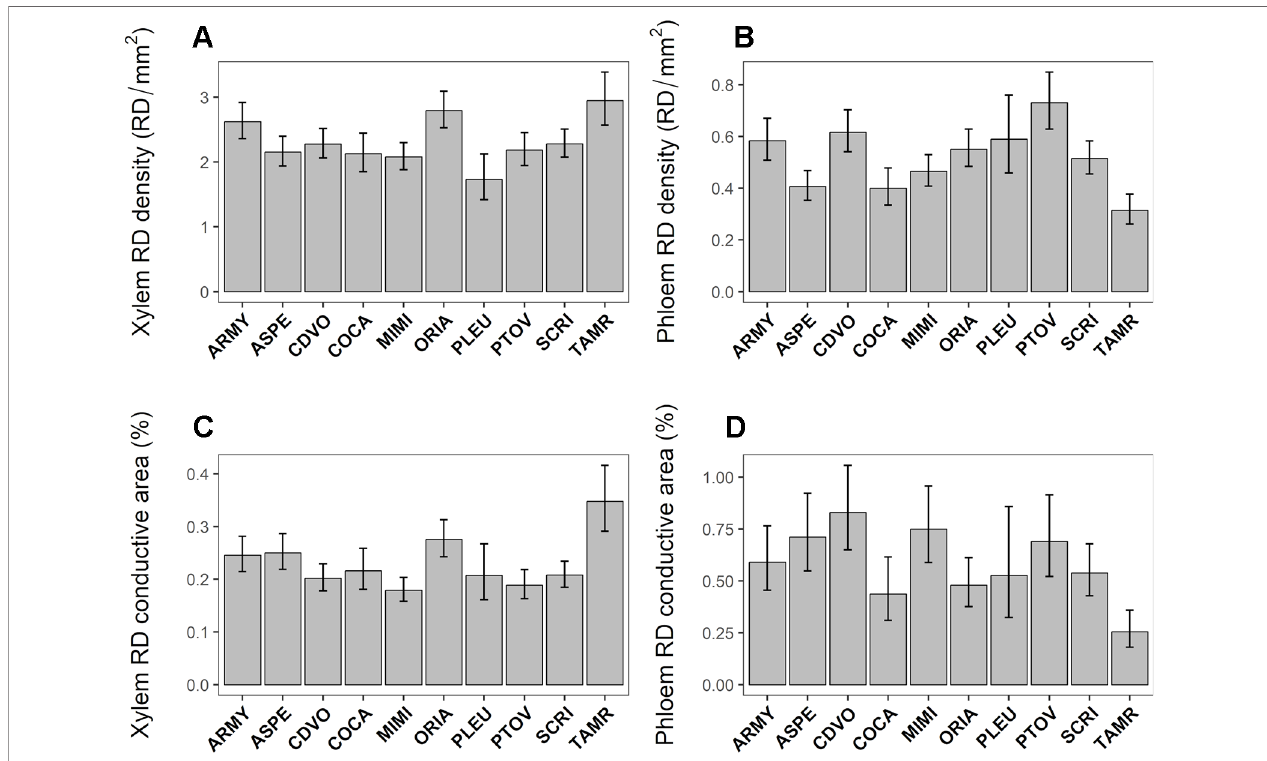
FIGURE 3 | Intraspeci fi c genetic variation in constitutive resin duct density (RD density, RD/mm 2 , panels A and B ) and relative conductive area (RD conductive area, %, panels C and D ) in the xylem (A , C) and phloem (B , D) among 10 Pinus pinaster populations covering a south – north latitudinal gradient. Bars represent population least square means ± SE extracted from the mixed model (Control plants; N = 63).